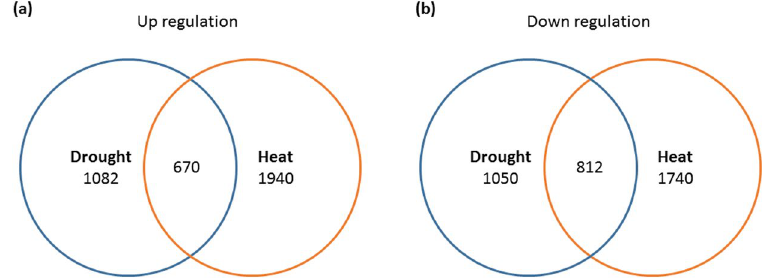
Figure 2. Number of ( a ) up- and ( b ) down-regulated genes in A. stolonifera under drought and heat stress, respectively, compared with control condition. The cutoff threshold was set as FDR >